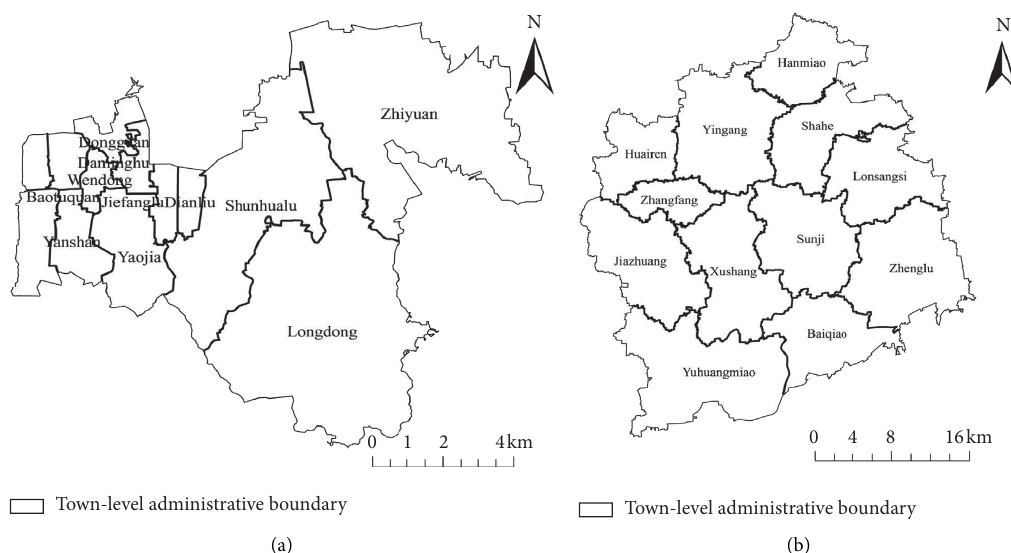
Figure 2: (a) Administrative division map of Lixia County. (b) Administrative division map of Shanghe